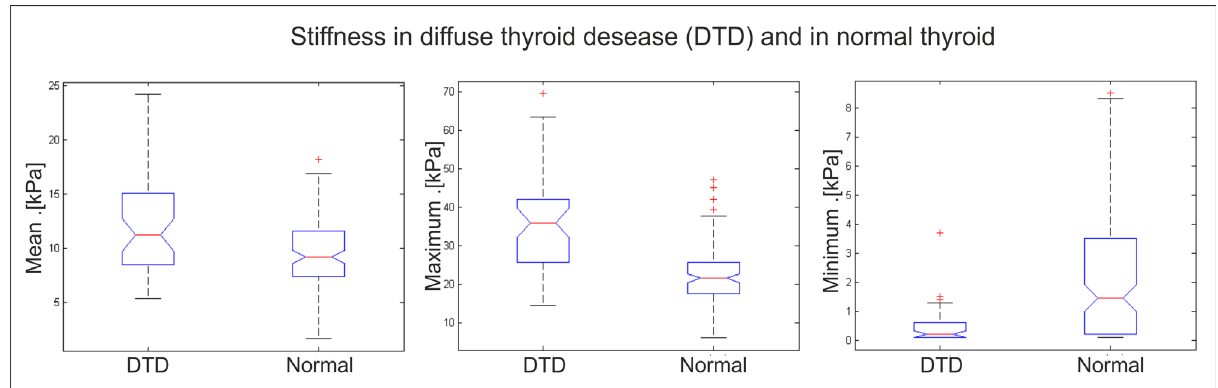
Fig. 2. Mean, maximal, and minimal stiffnesses of the thyroid gland in patients with diffuse thyroid disease and in healthy vol-